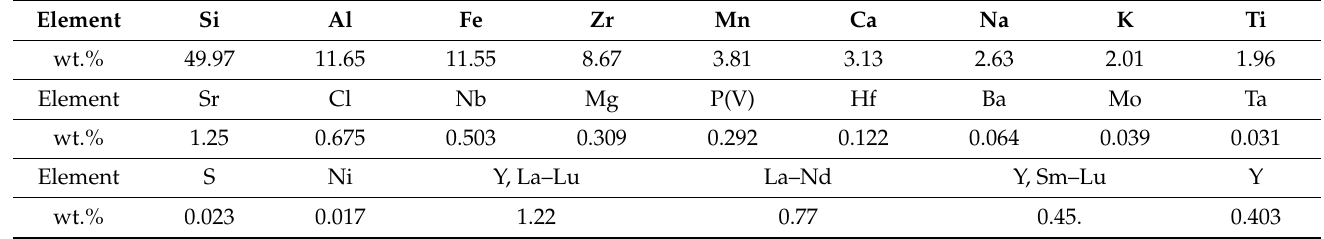
Table 2. Elemental composition of the eudialyte concentrate.